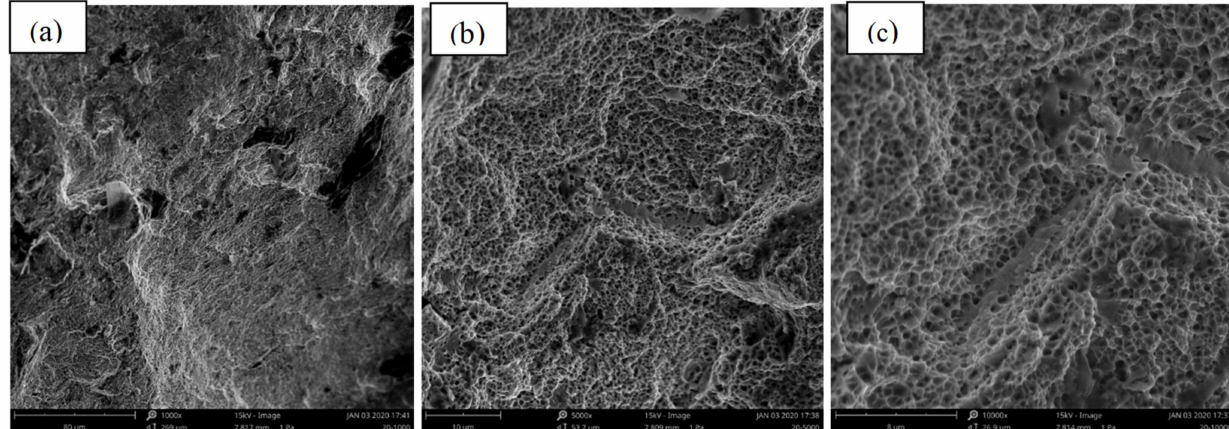
Figure 11. The fracture morphology of group 20—High Tensile Strength in Table 4, ( a ) × 1000, ( b ) × 5000, ( c ) ×